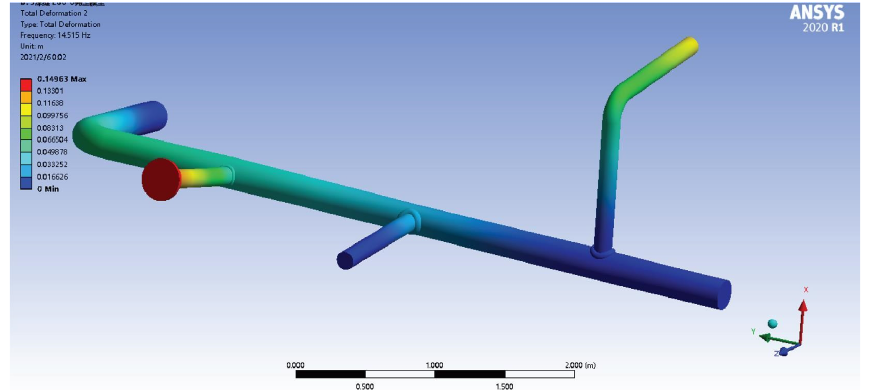
Figure 13: Second modal shape of model 1.